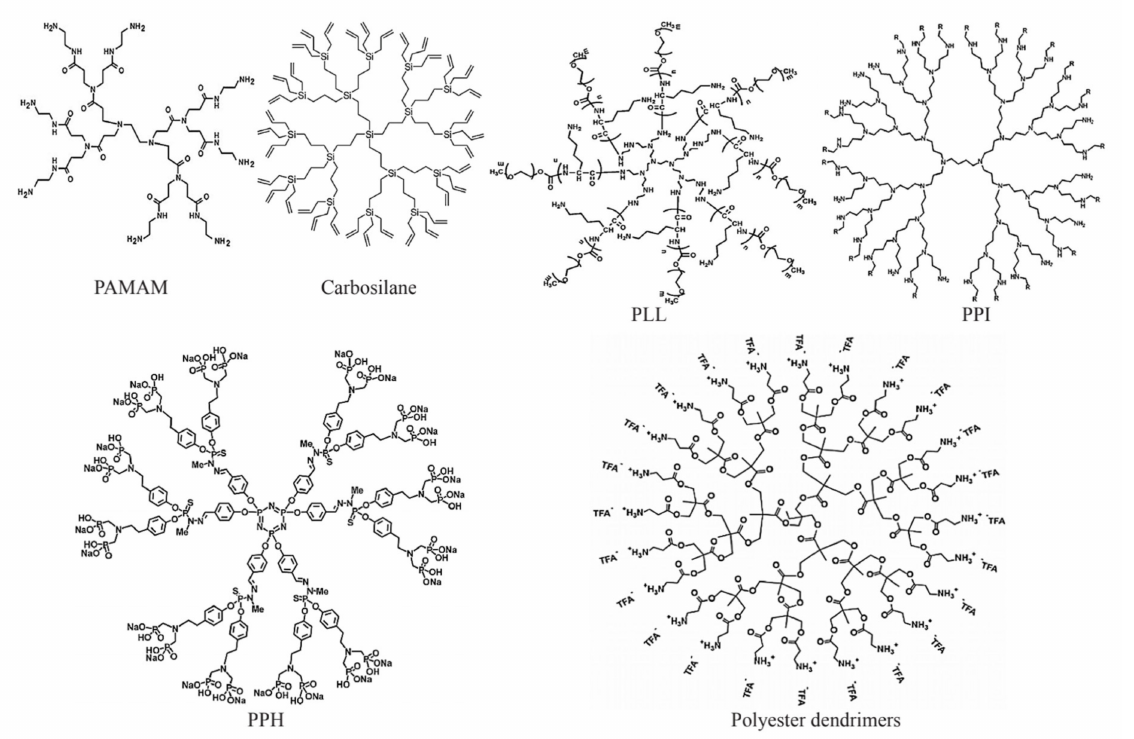
Figure 4. Samples of dendrimers [92,94,98,107–109]. PAMAM: PAMAM-G1.0-dendrimer. PPI: PPI-G4 dendrimers. PLL: PEI-g-(PLL-b-PEG). Carbosilane: carbosilane glycodendrimer. PHH: azabisphosphonate-capped dendrimer. Polyester dendrimers: 2,2-bis(methylol)-propionic acid